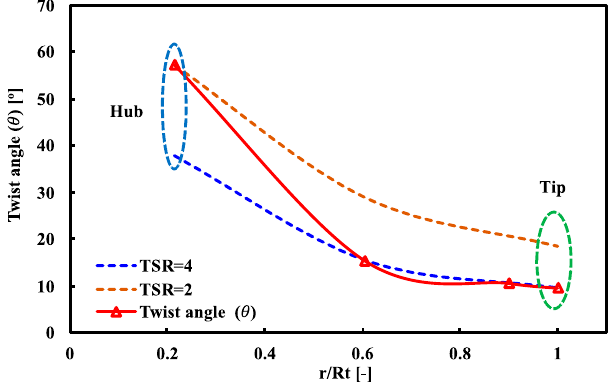
Figure 4. Twist angle distribution along the blade span.